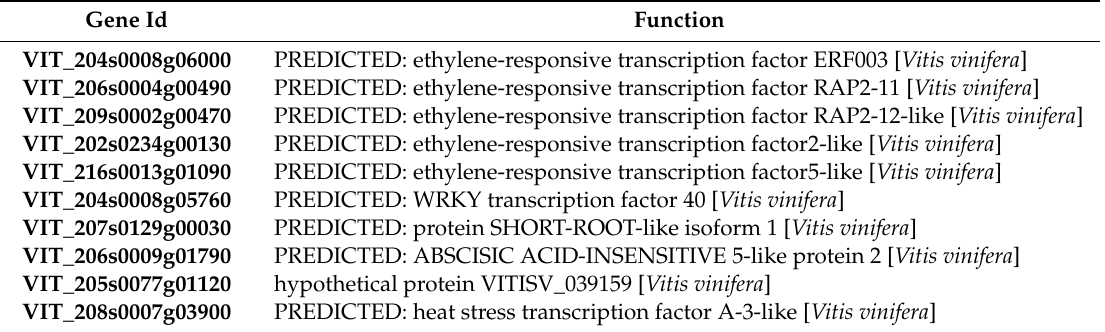
Table 1. Putative transcription factors in DNA pull